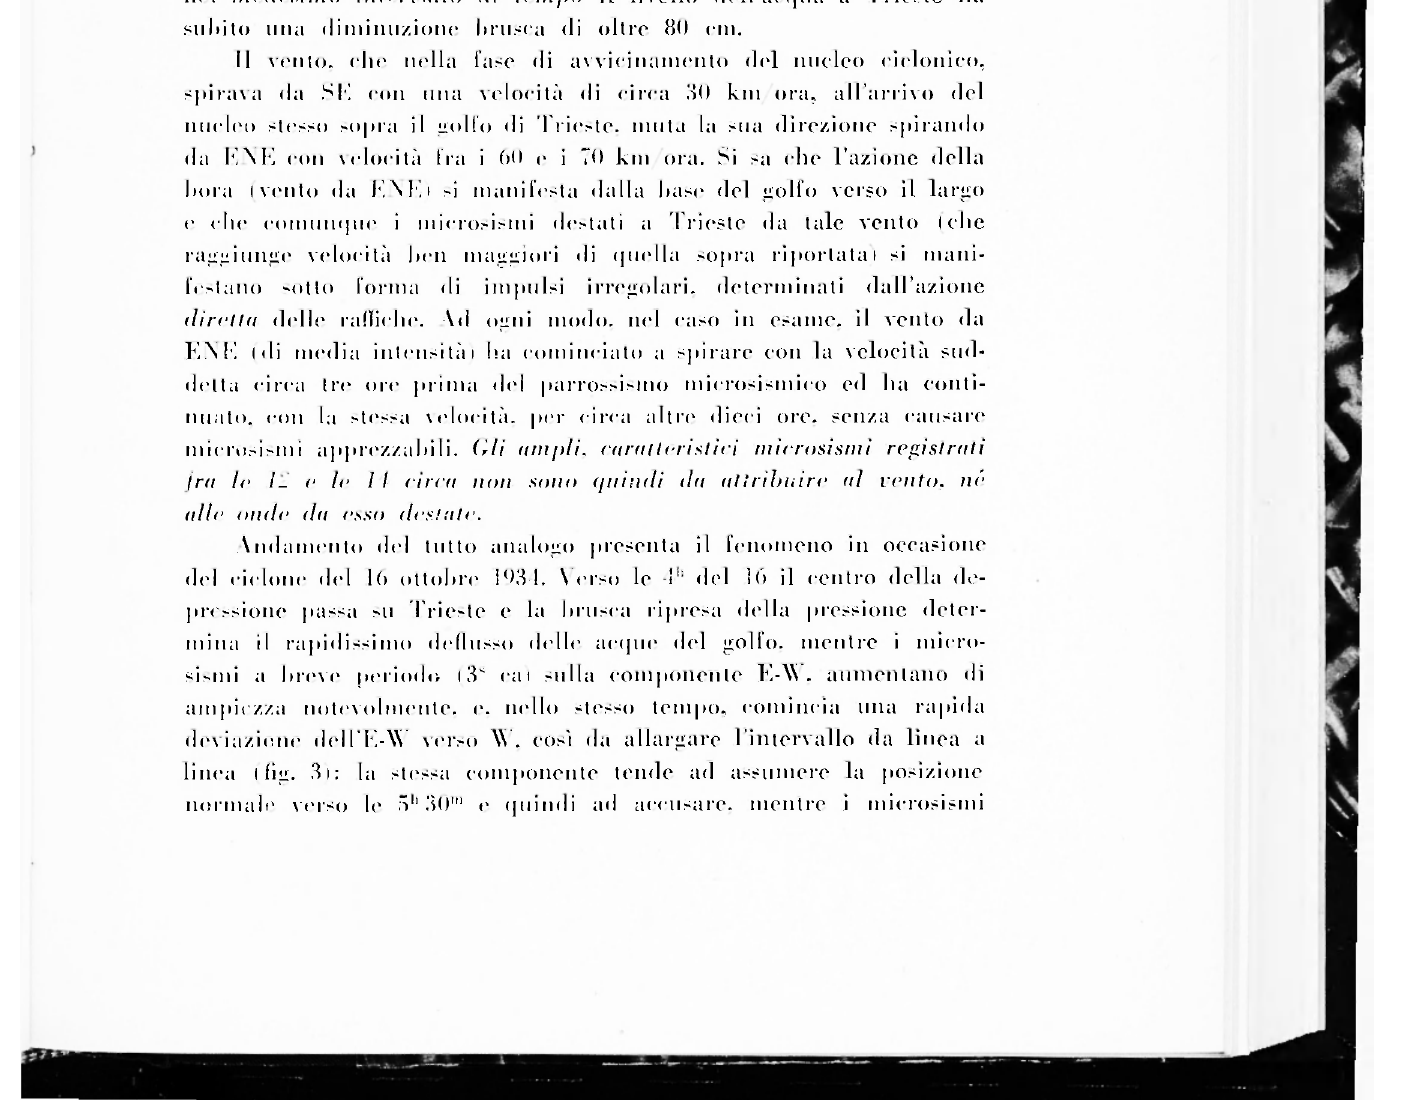
linea (fìg. 3l: la stessa componente tende ad assumere la posizione normale verso le 5 h 30'" e quindi ad accusare, mentre i